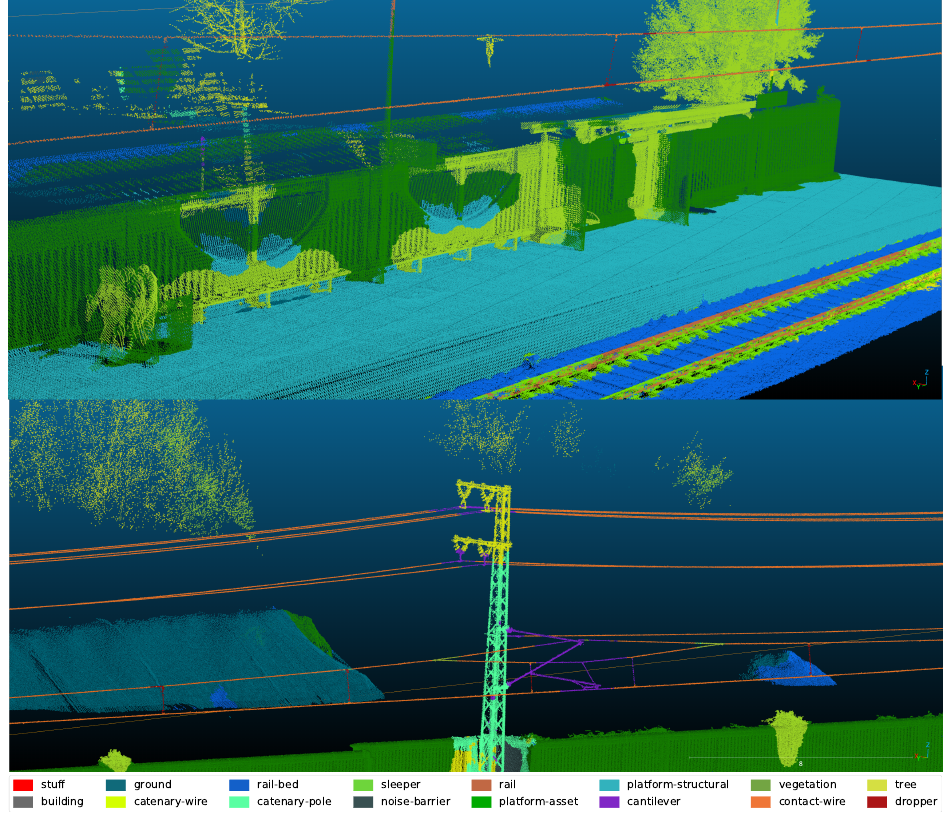
Figure 7. Detection quality after priming and before finetuning. Some classes such as platform– structural or contact–wires are well-detected. In contrast, rails and sound barriers are detected with very low confidence. A version after finetuning (second experiment) is shown in Figure